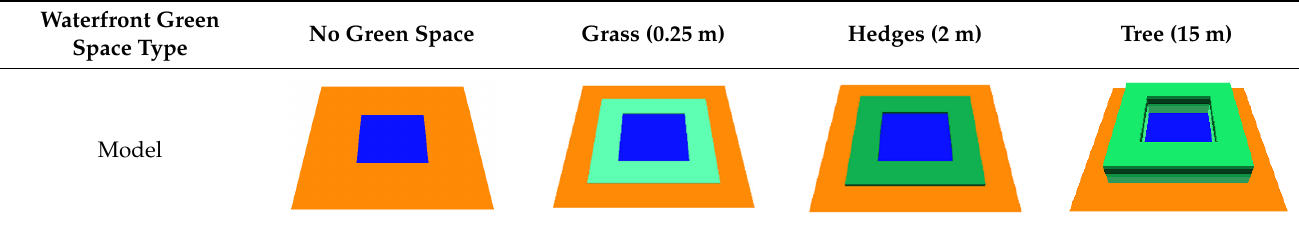
Table 5. Model settings for different waterfront vegetation types.